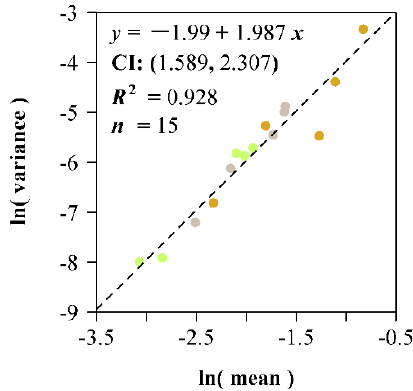
Figure 9. Taylor’s power law for leaf dry weight of the 15 species of plants. The colored points represent the observations, and the black dashed line represents the reduced major axis regression line. The three colors represent the three families, and each point represents one species. Furthermore, y represents the natural logarithm of the variance of leaf dry weight in g, x represents the natural logarithm of the mean of leaf dry weight in g, CI represents the 95% confidence interval of the slope, R 2 is the coefficient of determination used to measure the goodness of fit, and n represents the number of data points (i.e., the pairs of means and variances of leaf dry weight for different species).